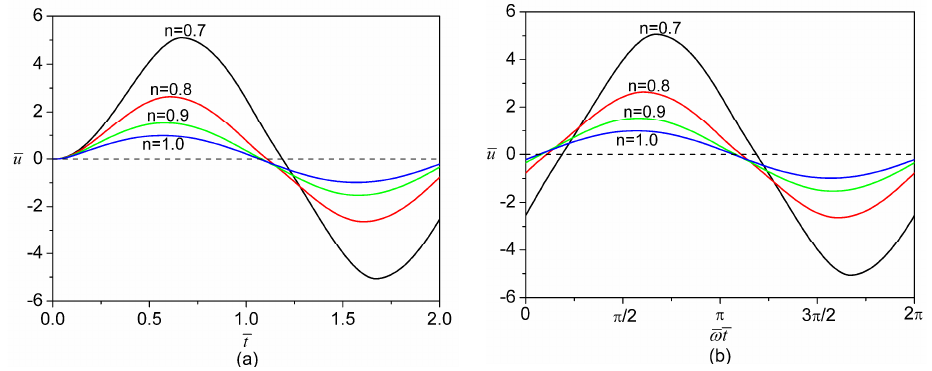
Figure 6. Steady-state oscillating axial velocity profiles of a power-law fluid with n = 0.8 at different phases in a half period from ω t = 0 to ω t = π when E 0 = 1, ψ w = − 1 and ω = π . There are seven groups of velocity profiles differentiated by different colors and each group represents the profiles at a given AC phase. In each group, the solid line is the velocity profile at y = 0 and the dash line is the profile at y = 0.35. The group with black color represents the profiles at ω t = 0; the group with red color represents the profiles at ω t = π /5; the group with green color represents the profiles at ω t = 2 π /5; the group with blue color represents the profiles at ω t = π /2; the group with cyan color represents the profiles at ω t = 3 π /5; the group with magenta color represents the profiles at ω t = 4 π /5 and the group with dark-yellow color represents the profiles at ω t = π . On the straight dot line, u = 0. Figure 7 presents the comparison of transient velocity development for different values of fluid behavior index at both the start-up stage and the steady-state oscillation. After turning on the AC electric field at 0 t = , it is seen from Figure 7a that the fluid at the transverse center ( 0 y z = = ) remains quiescent for a very short period of time. At this moment, the momentum generated inside the EDL is still limited to the regions near the channel walls and therefore needs time to diffuse to the bulk liquid. After a certain amount of time, the momentum is gradually transferred to the bulk liquid and then the liquid starts to move. The fluid with a larger fluid behavior index responds more promptly to the applied AC field and then reaches the peak velocity more quickly. This is consistent with the case of the DC electric field in which the fluid with a larger fluid behavior index reaches the steady state more quickly. When the flow attains the steady-state oscillation (Figure 7b), the velocity fluid behavior index, as is indicated in Figure 7c. We also note from Figure 7b that from one peak to its corresponding trough, power-law fluids with a smaller fluid behavior index experience more significant acceleration. Furthermore, the amplitude of oscillating velocity increases as the fluid behavior index